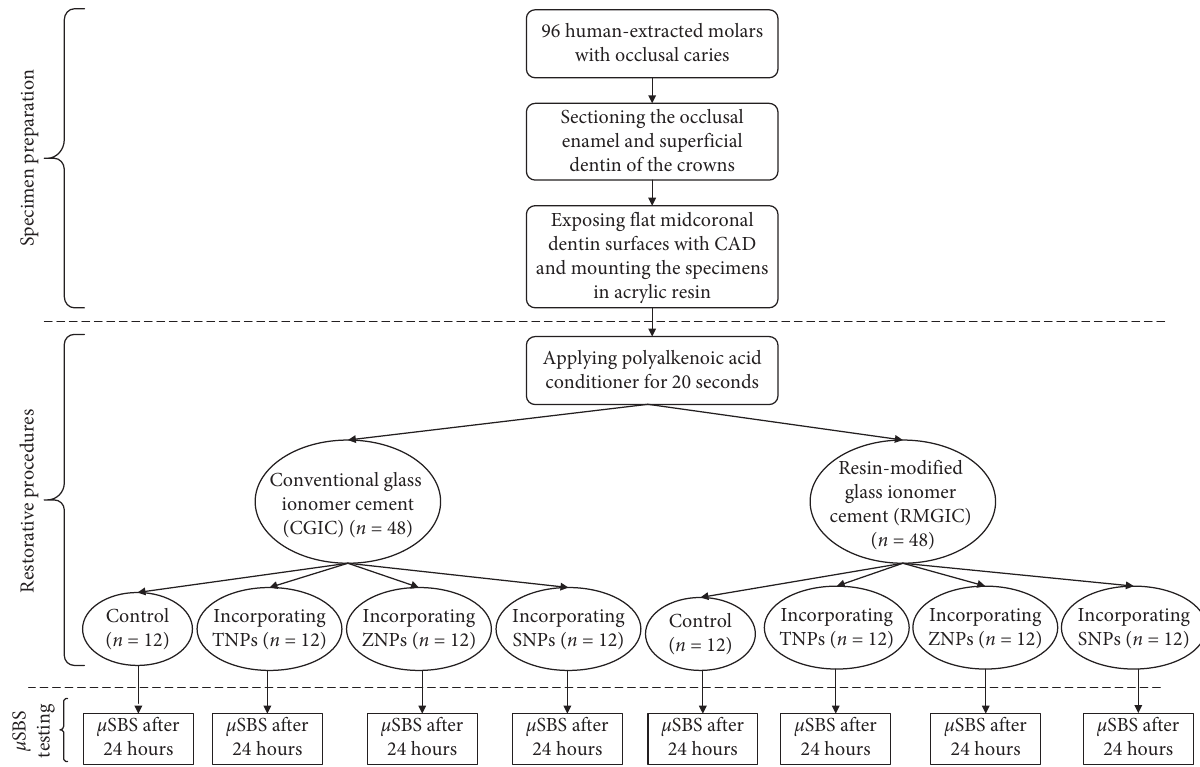
Figure 1: Diagram of the study design. CAD: caries-affected dentin; TNPs: titanium nanoparticles; ZNPs: zinc nanoparticles; SNPs: silicon nanoparticles; μ SBS: microshear bond